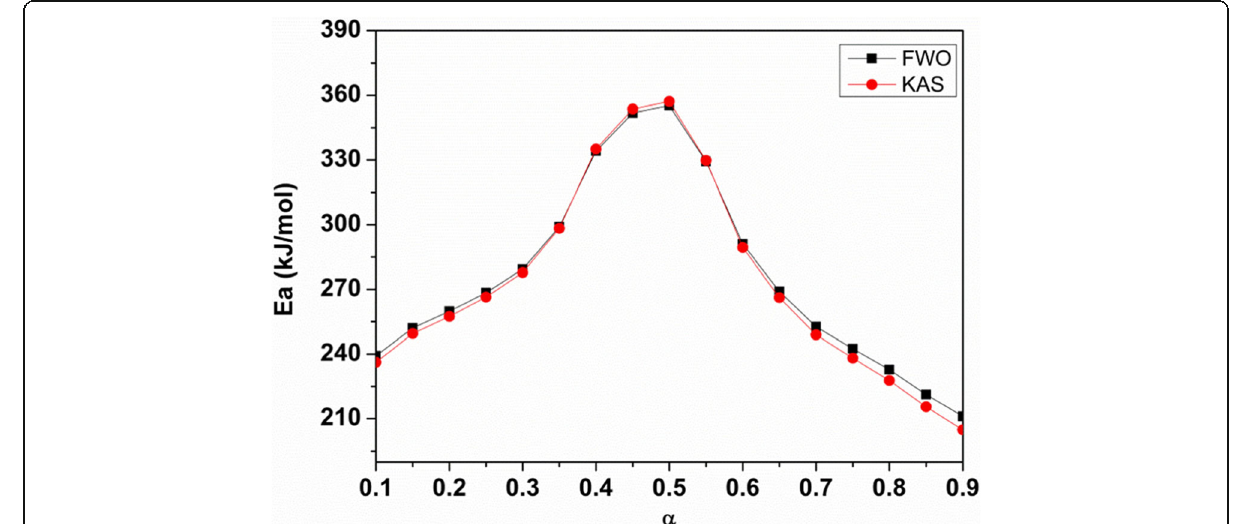
Fig. 7 Activation energy obtained from FWO and KAS methods as a function of